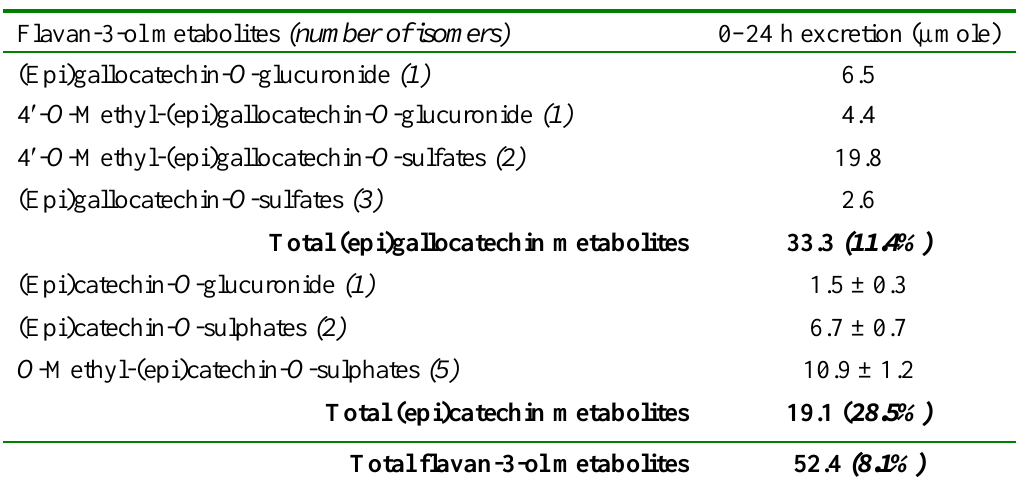
Table 3. Quantification of the major groups of flavan-3-ol metabolites excreted in urine 0–24 h after the ingestion of 500 mL of Choladi green tea by ten human volunteers. Data expressed as mean values in µmol ± standard error (n = 10). Italicised figures in parentheses indicate amount excreted as a percentage of